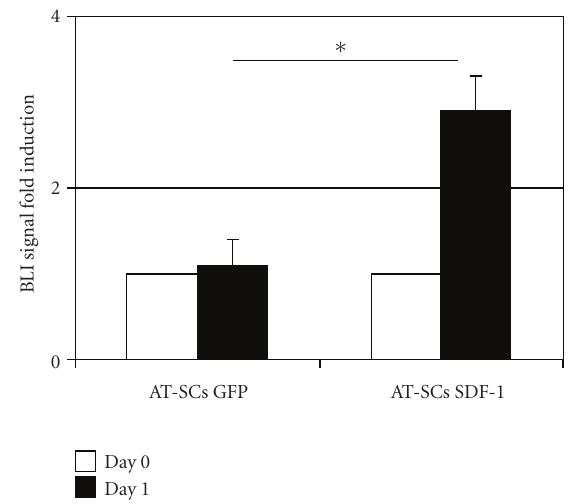
Figure 8: Topically administration of AT-SCs expressing luciferase and overexpressing SDF-1. SDF-1 overexpression promotes enhanced survival/proliferation of administered cells at the lesion site 1 day after wounding and cell administration, as assessed by BLI. Values are expressed as mean ± SEM indicated by error bars; n = 3, ∗ P < .